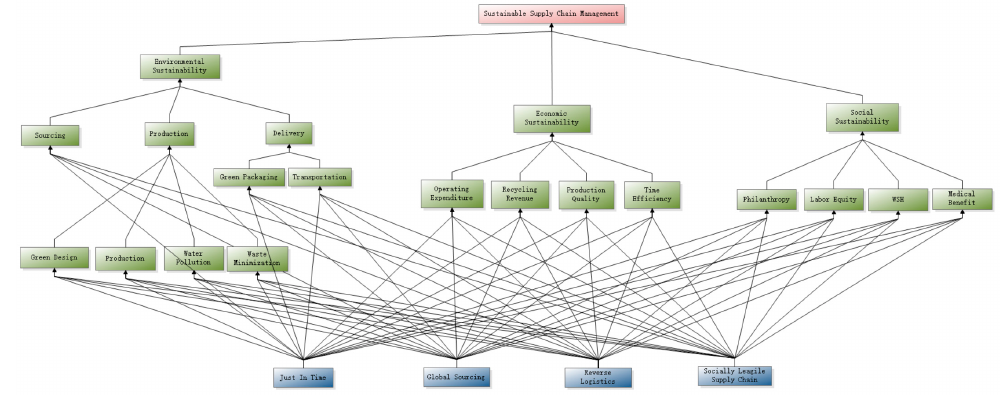
Figure 4. AHP Model.